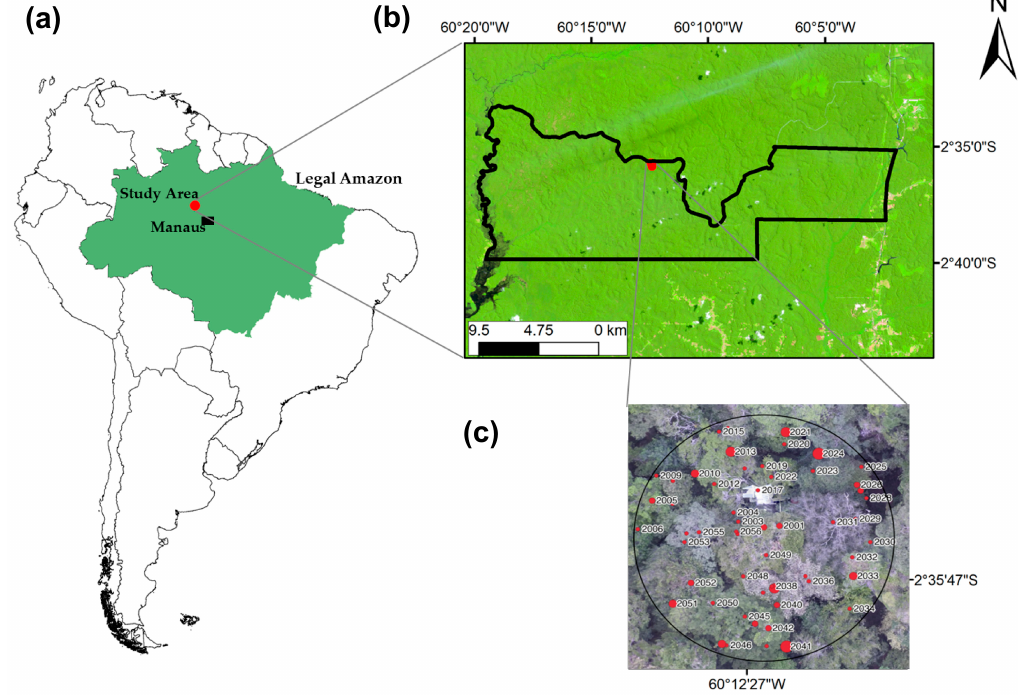
Figure 1. The locations of the monitoring plots in a central-eastern Amazonian terra-firme forest (situated in the study area ca. 70 km north of Manaus, Brazil): ( a ) The red points represent the geographic location of the survey plots situated in the Cuieiras Biological Reserve (delineated by the black border ( b )), as well as the respective location and diameter size of individual trees analyzed in this study (identified by the respective point size and labeled by individual tree IDs ( c )).